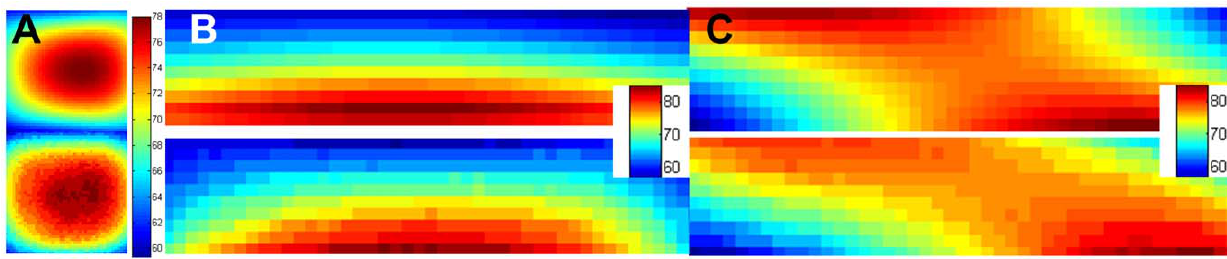
Figure 5. Validation analysis of the electromagnetic simulations. Numerical estimation (top) vs. AFI measurements (bottom) of the flip angle in the: ( A ) xy ( B ) xz and ( C ) yz planes.